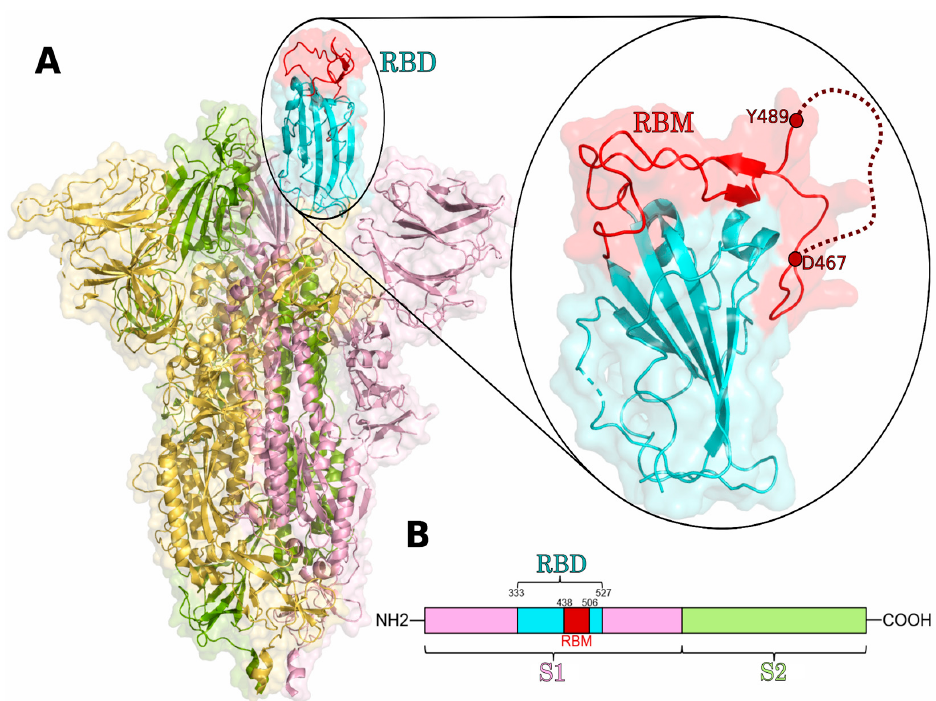
Figure 1. ( A ) Structure of the trimeric S-protein (each monomer is depicted with its own color) (PDB ID: 7fcd [18]). Insertion gives a closer look at the RBD (receptor-binding domain) (cyan) and its RBM (receptor binding motif) region (red); a dotted line connects amino acids D467 and Y489, indicating the commonly missing structural data. ( B ) Scheme of the domain architecture of S-protein superimposed on a primary structure.